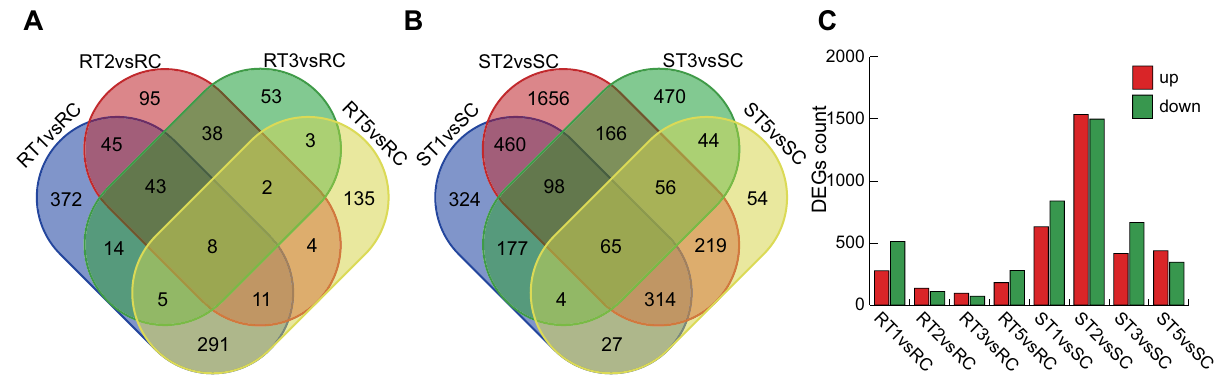
Figure 2. Differentially expressed genes (DEGs) across four time points after Px infection in resistant (TG-1) and susceptible cultivars (TG-5). ( A ) Venn diagram of DEGs in the resistant melon cultivar at each of four time points after Px. infections. ( B ) Venn diagram of DEGs in the susceptible melon cultivar at each of four time points after Px infections. ( C ) Distribution of up-regulated and down-regulated gene expression patterns across the four time points after Px infections in resistant and susceptible